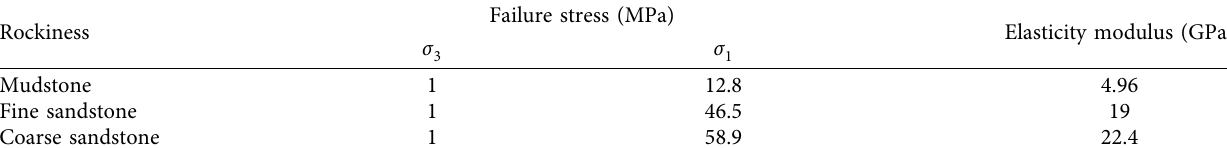
Table 3: Triaxial compression test of different lithology specimens.